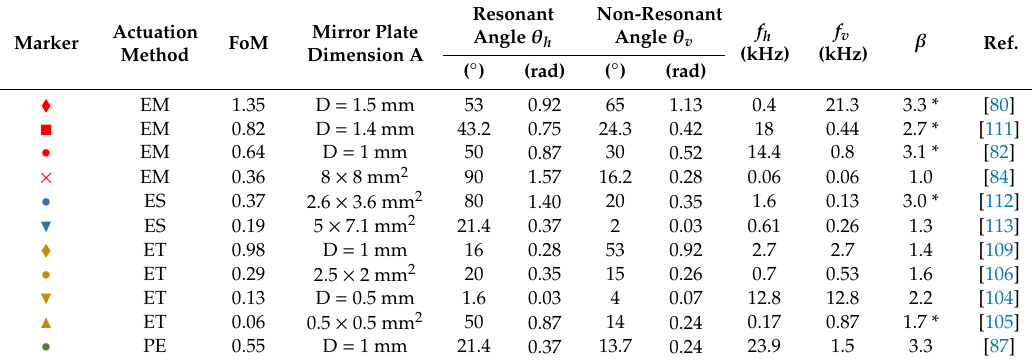
Table 6. Non-resonant plus resonant scanning 2D MEMS mirrors.